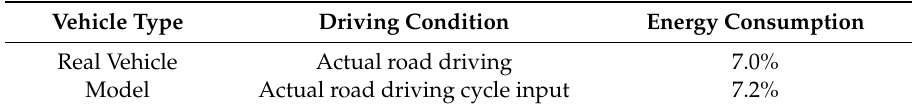
Table 2. Comparison of energy consumption between the real vehicle and the model for actual road driving.